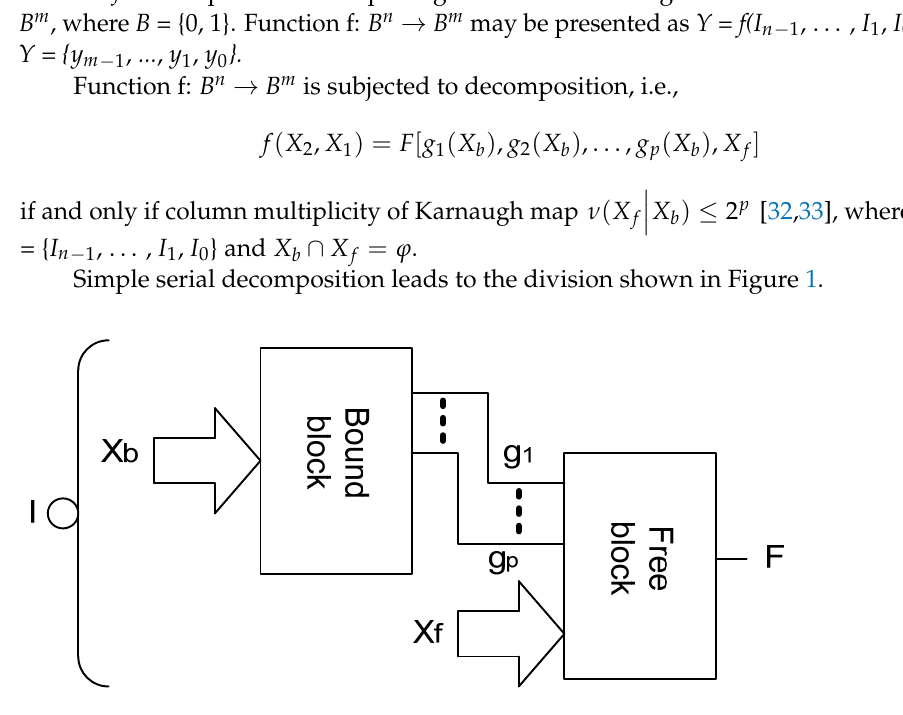
Figure 1. The essence of simple serial decomposition.